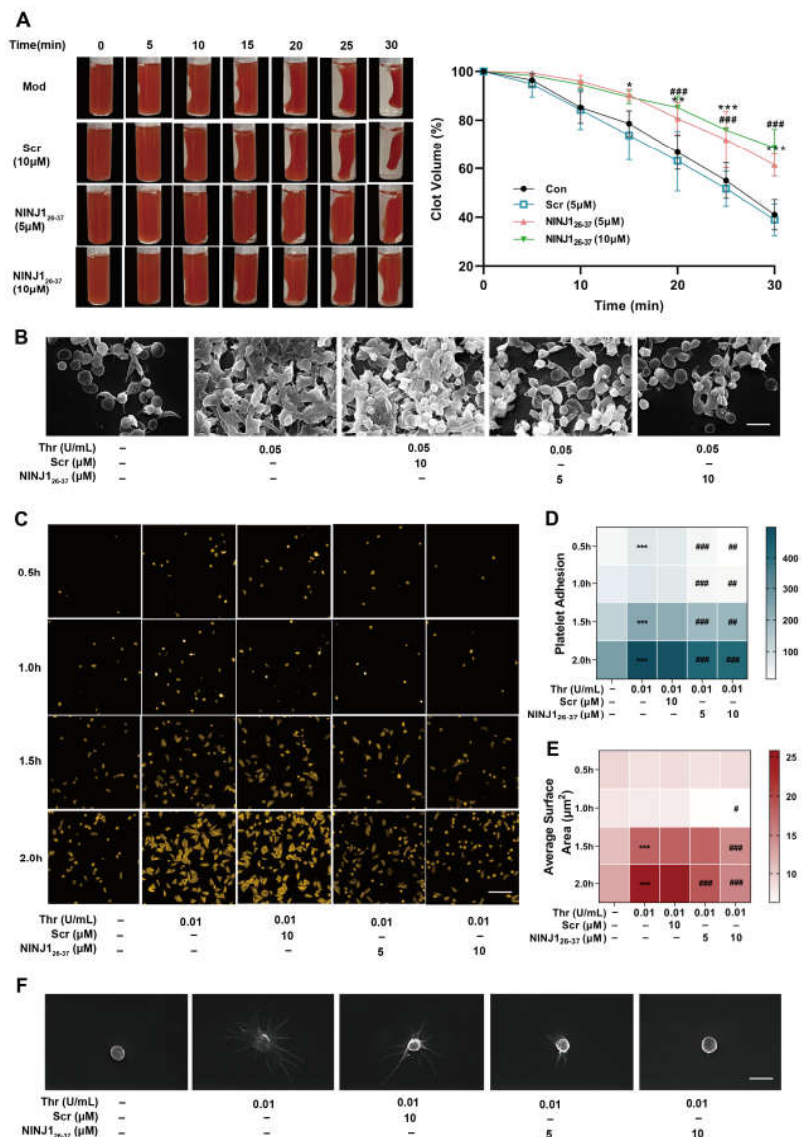
Figure 2. Inhibition of NINJ1 weakens platelet integrin signaling. ( A ) Clot retraction was measured for 30 min in washed platelets in fibrinogen, supplemented with RBC, after adding 1.0 U/mL thrombin in the presence of a vehicle, Scr (10 µ M), or NINJ1 26–37 (5 or 10 µ M). The left panels show representative images at different times. The right panel shows the quantification of clot size. Values are mean ± SEM, n = 4. Two-way ANOVA with Tukey’s multiple comparison test. ( B ) Scanning electron microscopy was performed to assess the extent of platelet aggregation and the ultrastructure. Scale bar represents 2 µ m. ( C ) Washed platelets adhere to and spread on fibrinogen with thrombin (0.01 U/mL) stimulation at 37 ◦ C for 0.5 to 2 h. Once fixed and stained, the platelets were observed with a fluorescence microscope. Images were acquired, and the spreading area of single platelets was measured using ImageJ software, with pixel number as the unit of size. Scale bar represents 10 µ m. ( D ) Number of adhesion and ( E ) surface areas of single platelets from seven randomly selected fields of three different tests. * p < 0.05, ** p < 0.01, *** p < 0.001 vs. resting platelets; # p < 0.05, ## p < 0.01, ### p < 0.001 vs. activated platelets. ( F ) Scanning electron microscopy was performed to assess the extent of platelet spread and the ultrastructure. Representative scanning electron microscopy images of platelets treated with vehicle, Scr (10 µ M), NINJ1 26–37 (5 or 10 µ M), and then stimulated with thrombin. Scale bar represents 1 µ